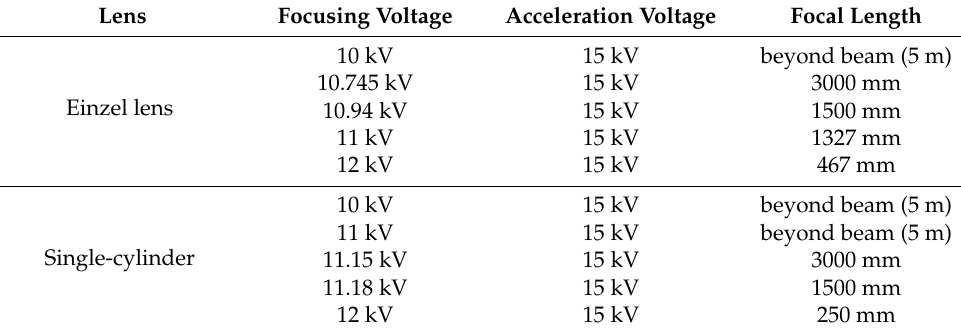
Table 3. Lens effect of focusing system based on SIMION simulations.